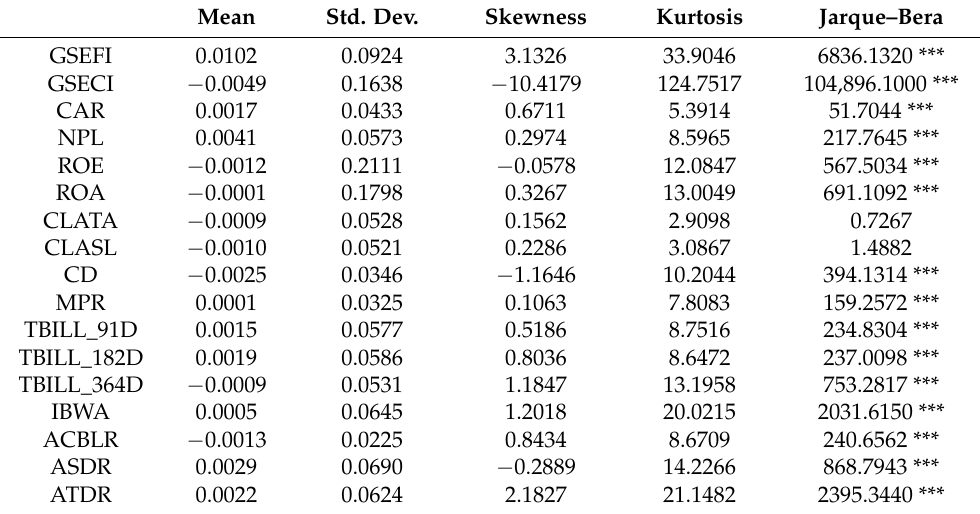
Table 1. Preliminary